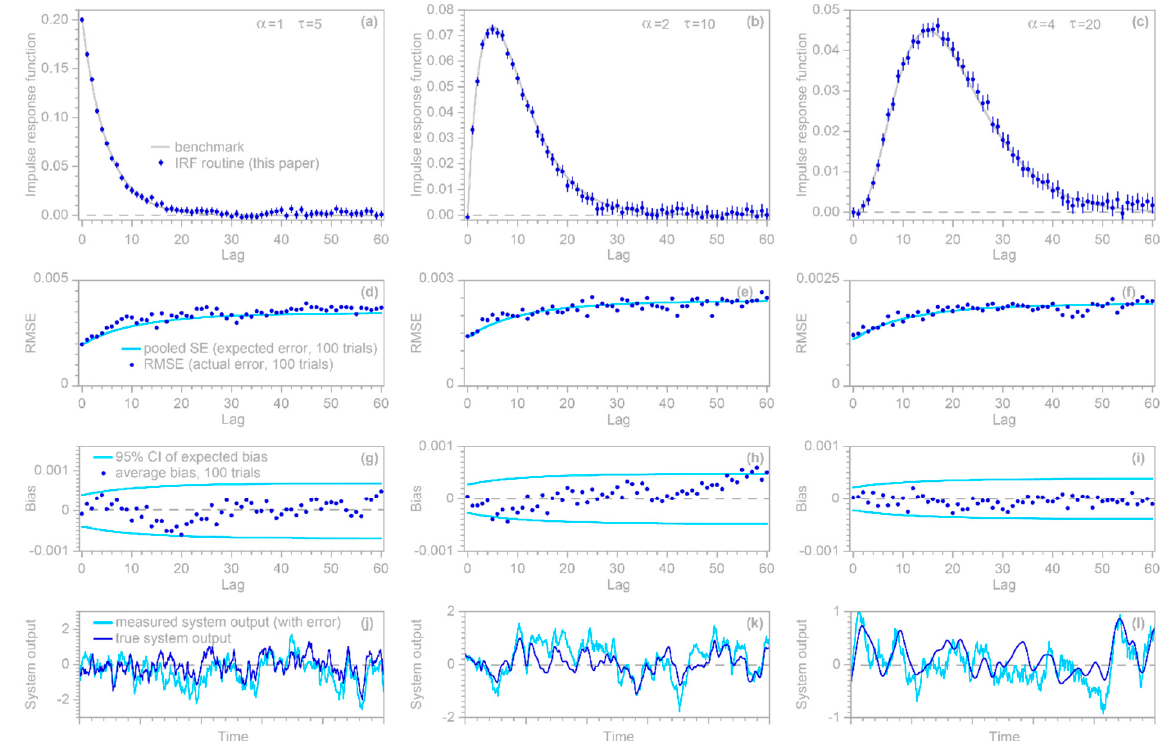
Figure 2. Benchmark tests of impulse response function (IRF) calculations. Top row ( a – c ): IRFs calculated from noisy time series (dark symbols), compared to the true convolution kernels (gray lines) used as benchmarks. Error bars indicate one standard error. Benchmarks are gamma distri- butions with shape factors of 1, 2, and 4 in the left, center, and right columns, respectively. Second row ( d – f ): test of standard error estimates, obtained by repeating the analysis in the top row for 100 different randomizations. The estimates of expected deviations from the benchmark (the pooled standard errors at each lag, shown by light blue lines) agree with the actual deviations from the benchmark (root mean square average of deviations from the benchmark at each lag, shown by dark blue symbols). Third row ( g – i ): dark blue points show the average deviation from the benchmark in 100 different randomizations of the analysis in the top row, and the light blue lines show the 95% confidence interval of average deviations from the benchmark. The dark points generally lie between the blue lines, indicating that the IRFs are unbiased. Bottom row ( j – l ): true convolution output y j (dark blue lines) and the ARMA noise-corrupted y j used as input to the IRF calculations (light blue lines). Five hundred time steps, equaling five percent of each time series, are